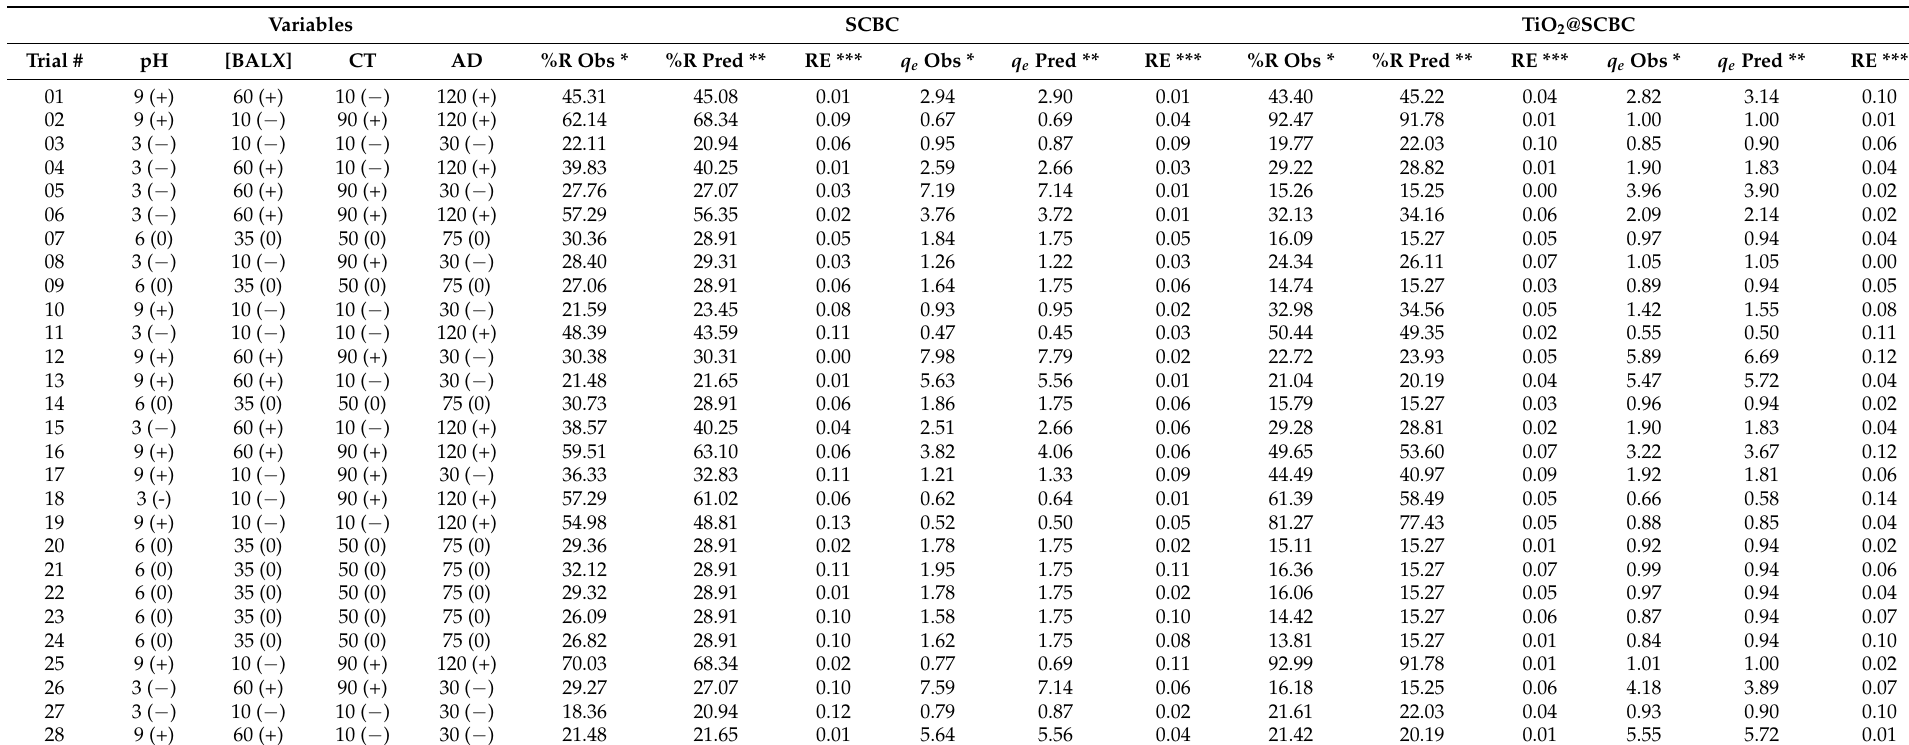
Table 2. Design of experiments employing PBD. Observed and predicted values for both responses and the calculated relative error (RE) are shown.